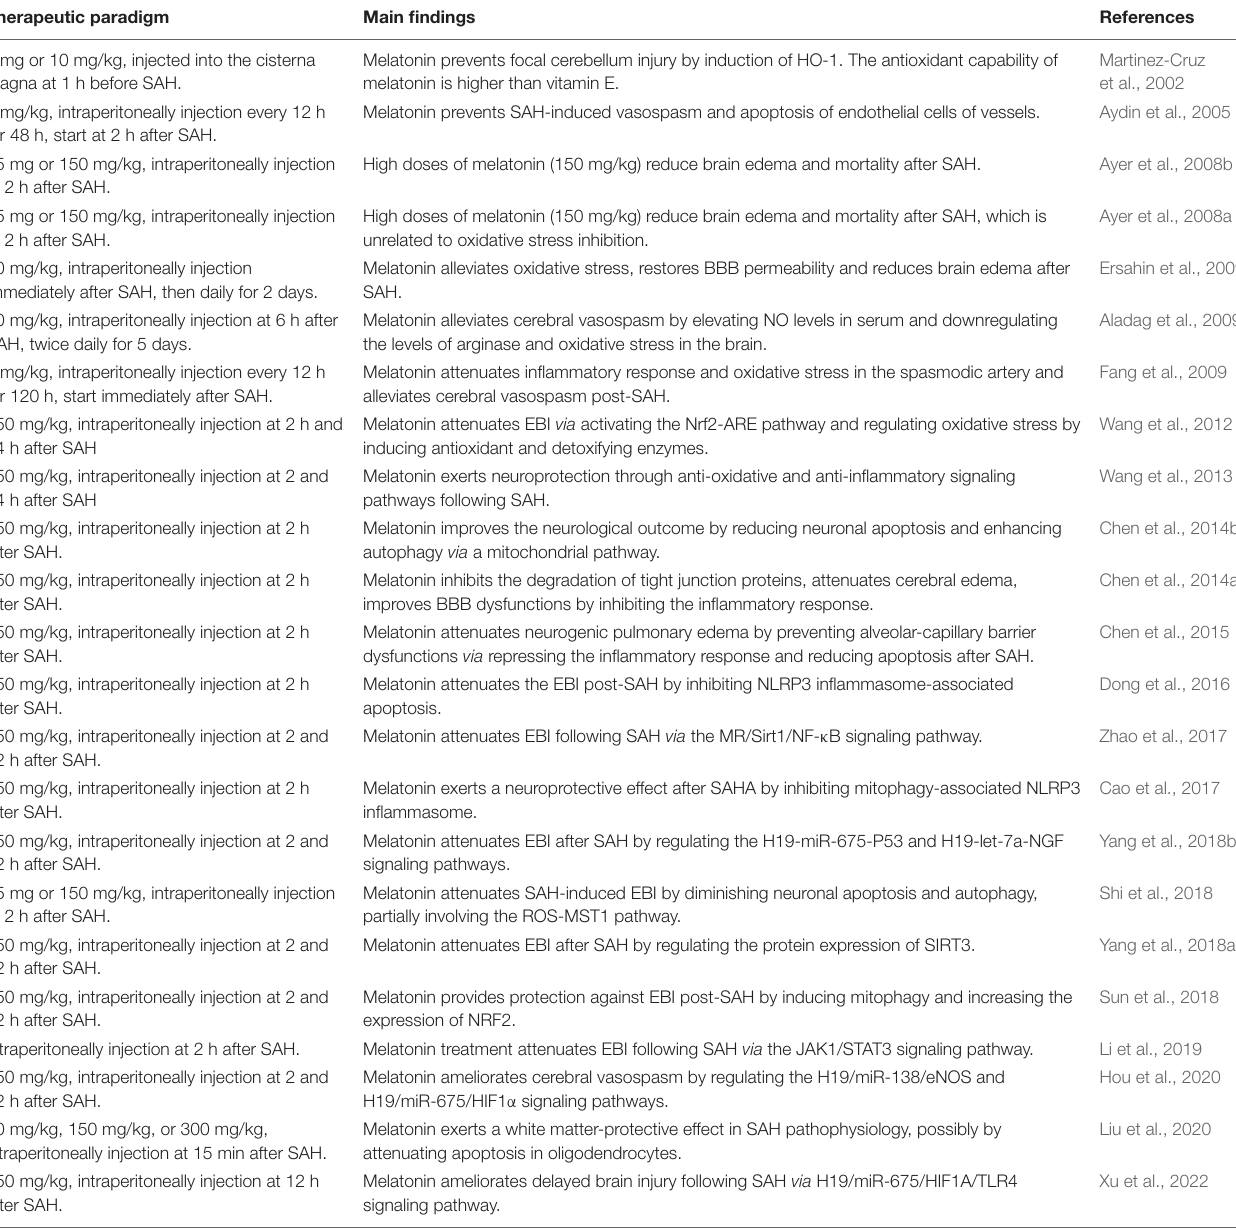
TABLE 1 | Neuroprotection of melatonin treatment in